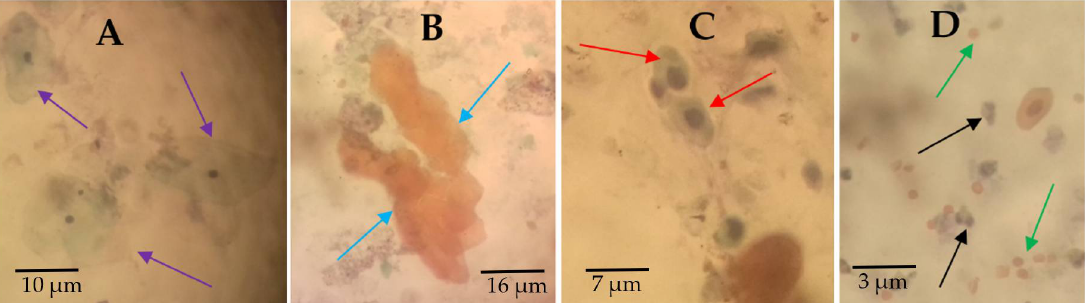
Figure 3. Urine cytology showing normal and abnormal urothelial cells. Papanicolaou-stained urine deposit smears showing ( A ) arrows pointing at normal urothelial cells from noninfected participants, ( B ) arrows pointing at anucleated hyperkeratotic clustered cells, ( C ) arrows pointing at squamous metaplastic cells, and ( D ) black arrows pointing at inflammatory cells and green arrows pointing at red blood cells. These pictures were chosen from different participants as representative observations (source of images: authors’ laboratory work).